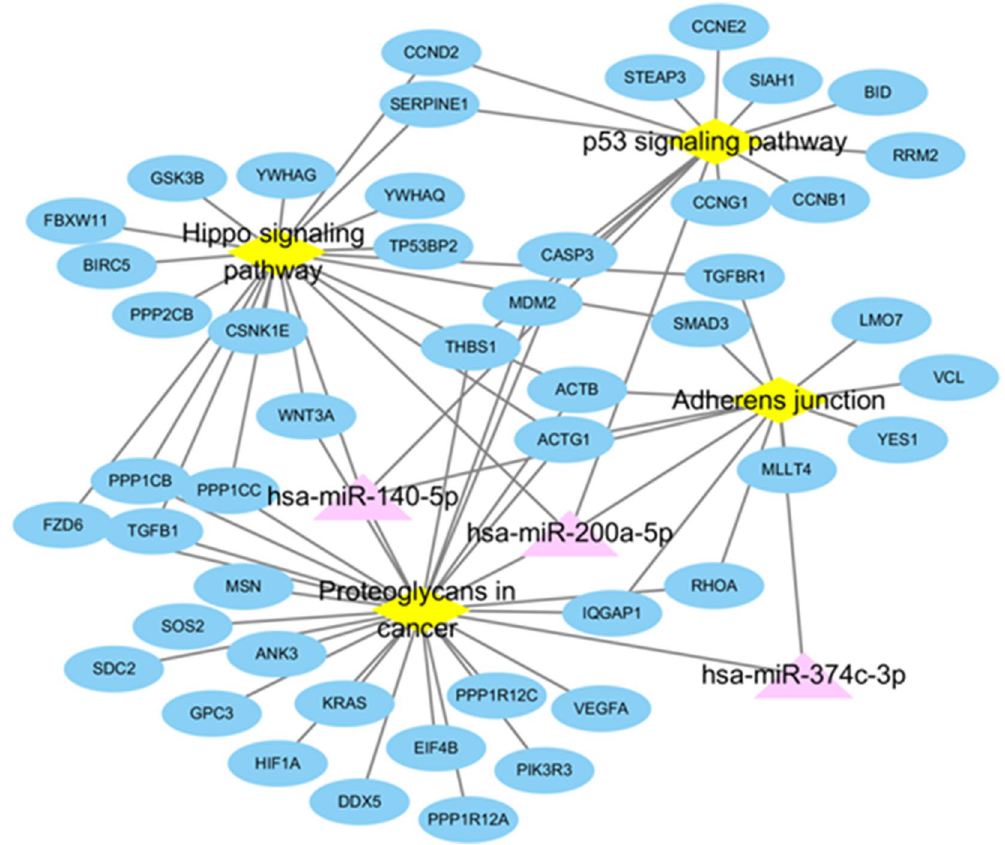
Figure 4. Predicted network of differentially expressed miRNAs (three by fold-changes in expression) between typical AMD and PCV eyes. AMD age-related macular degeneration, PCV polypoidal choroidal